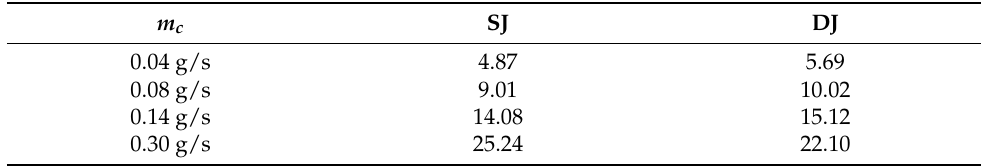
Table 4. The Area-averaged Nu number on impinging